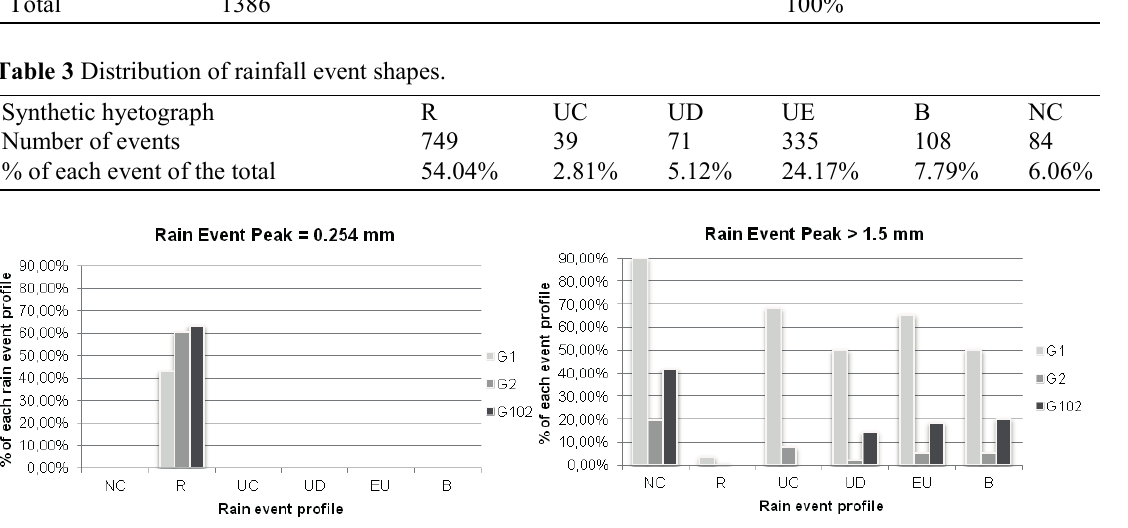
Fig. 3 Classification of rainfall events